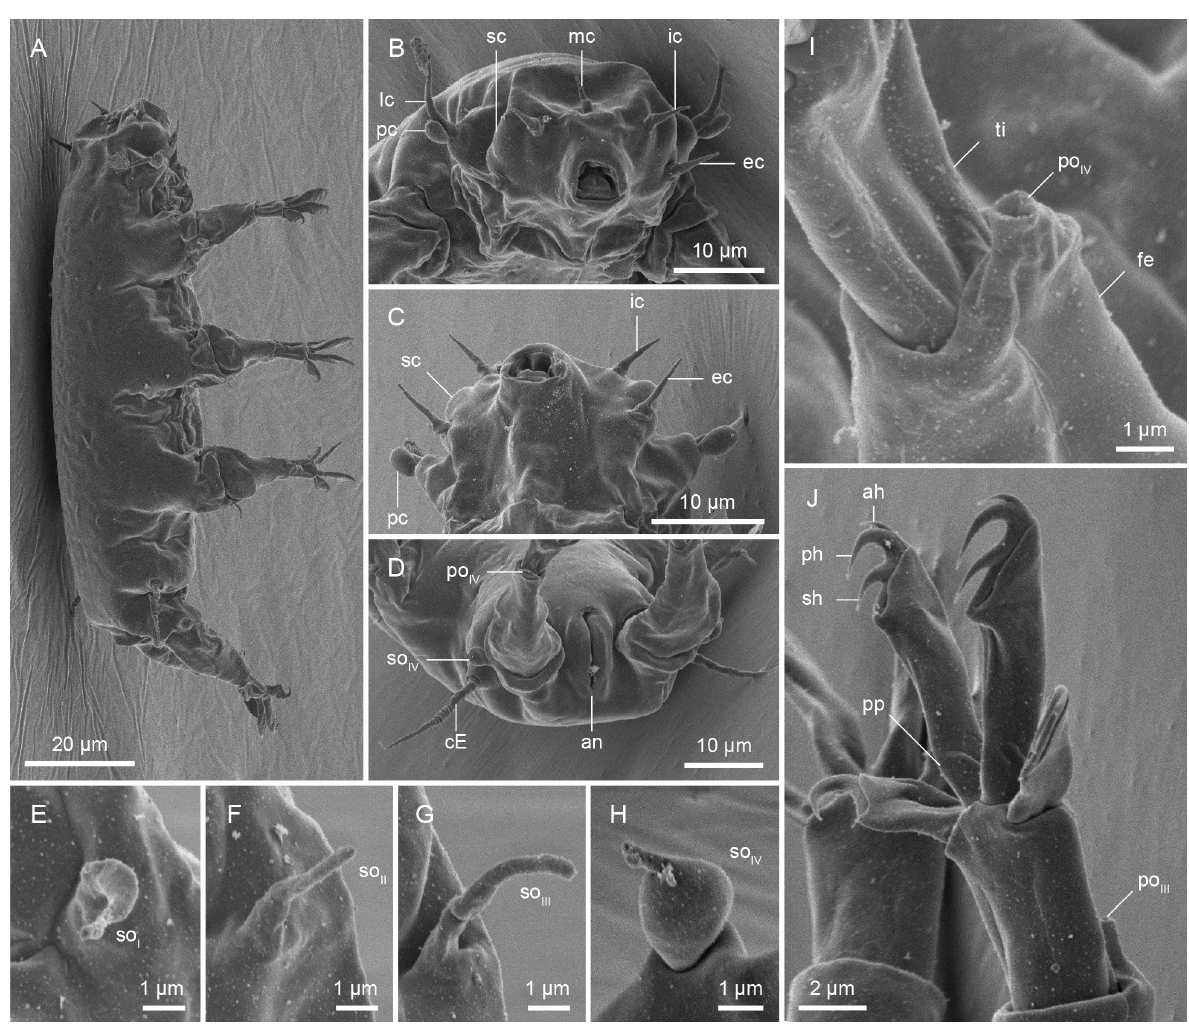
Figure 3. SEM micrographs of Cyaegharctus kitamurai gen. et sp. nov., four-claw juvenile paratype KUZ Z2627. A. Habitus